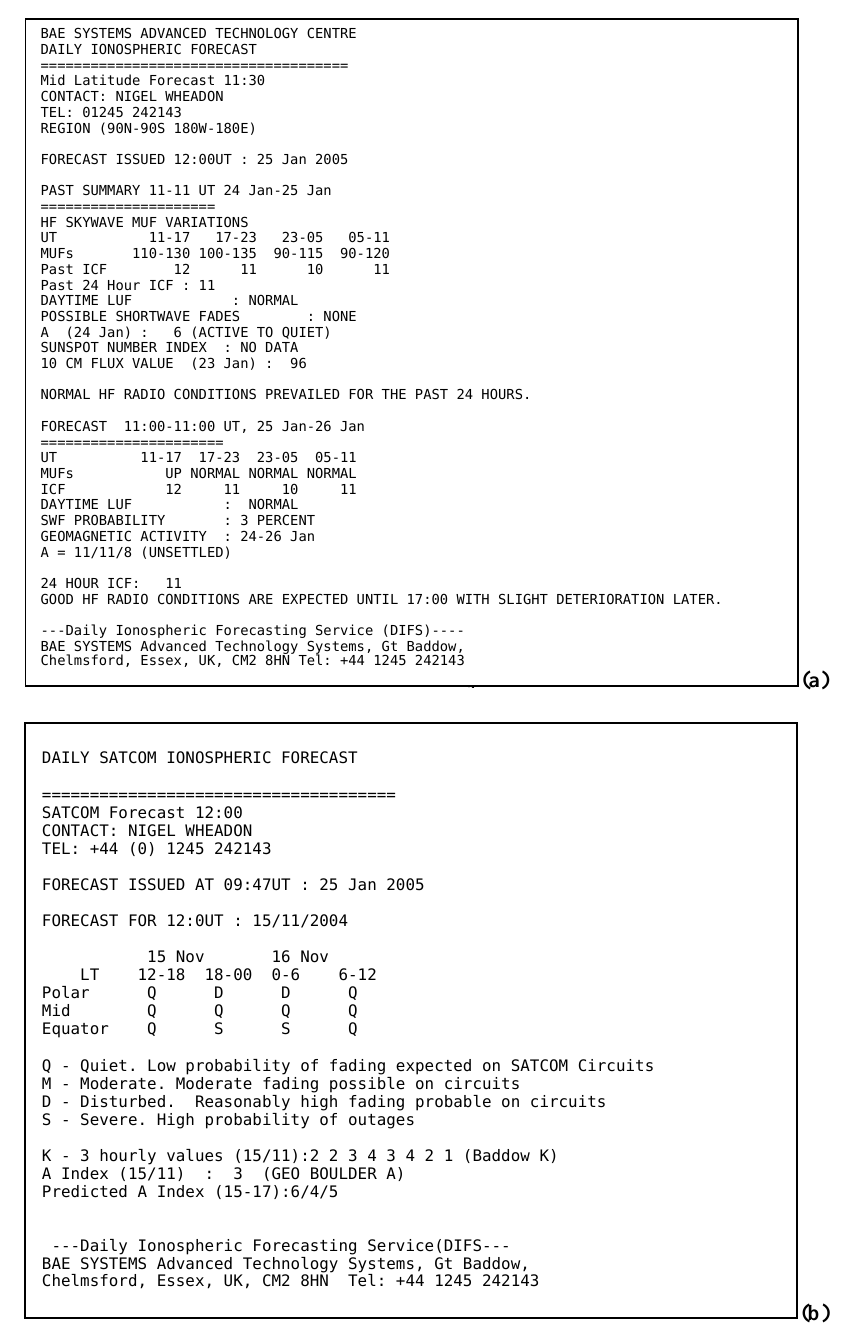
Fig 4-2 - SATCOM Forecast for 10th January 2005 Fig. 3. (a) HF Forecast for 24 January 2005; (b) SATCOM Forecast for 10 January